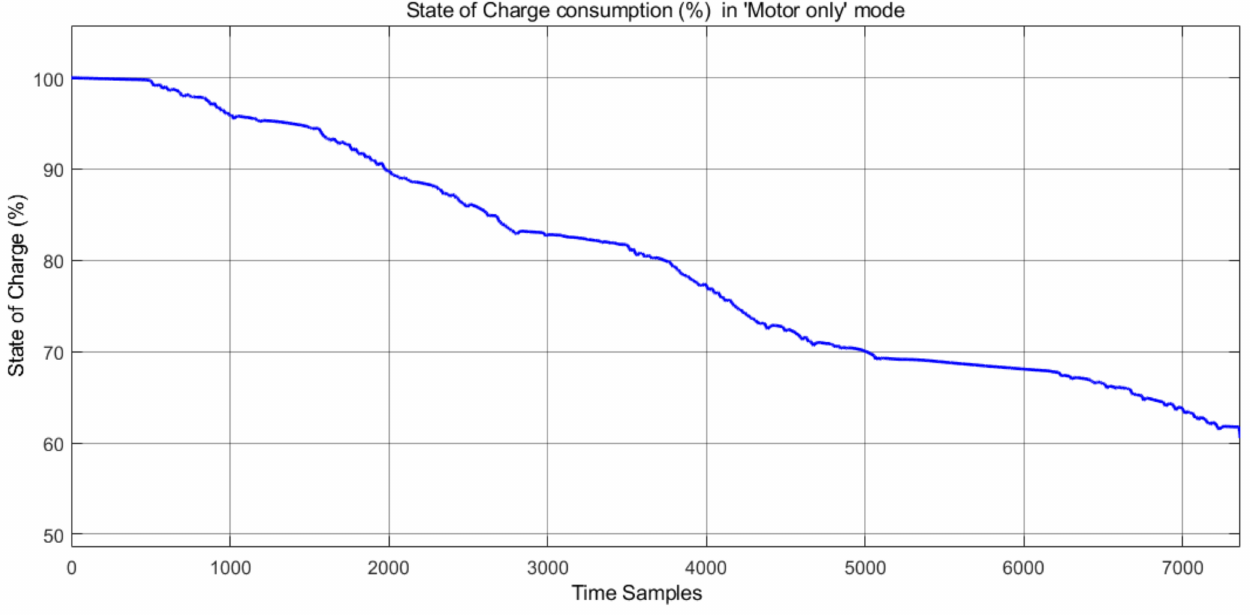
Figure 16. Simulation results for SoC during ‘Motor only’